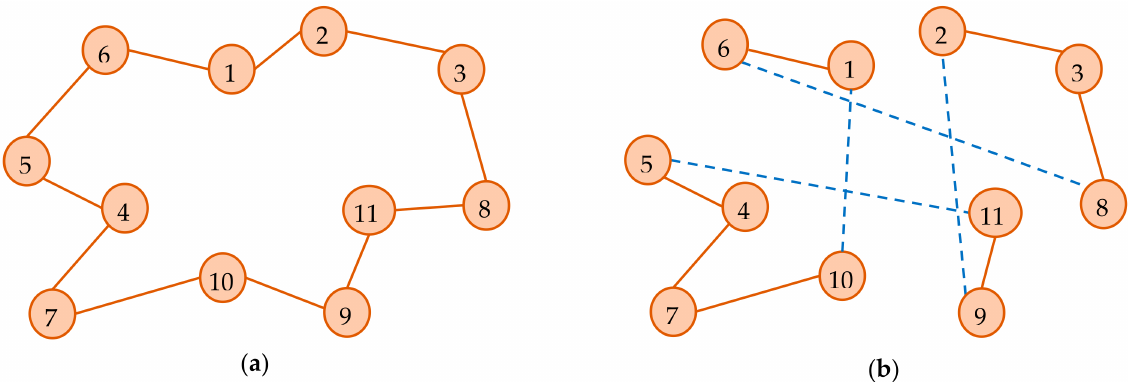
Figure 1. The double-bridge perturbation. ( a ) Initial path; ( b ) The path after double-bridge perturba- tion. The number in the circle represents the city, and the blue dotted line represents the path after reconnection. The pseudo-code of ILS is summarized in Algorithm 2. In Algorithm 2, XX indicates the individual in the